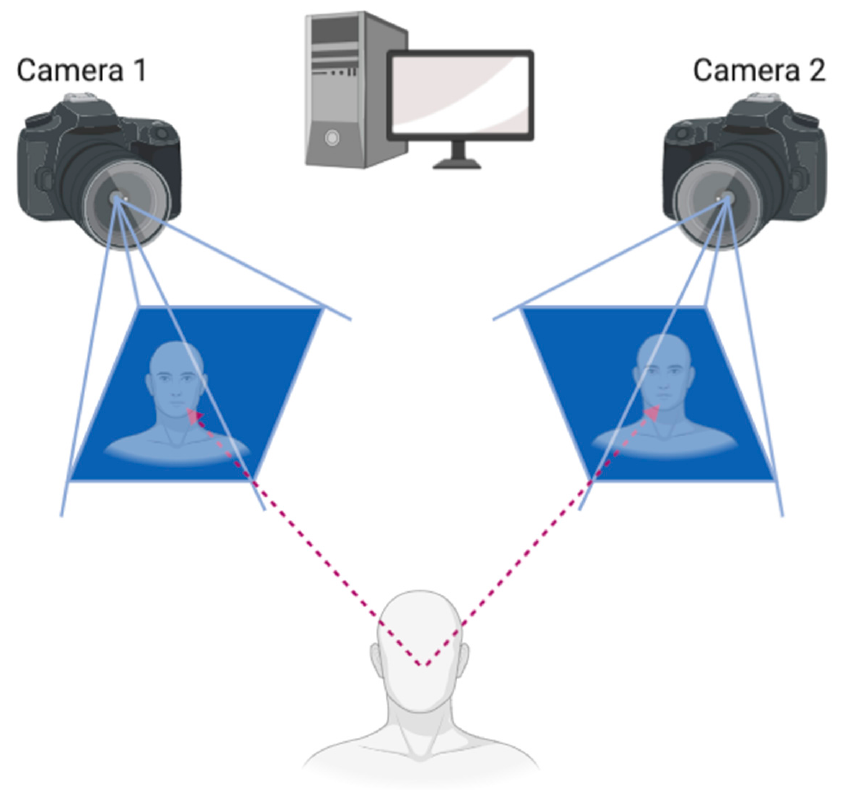
Figure 2. Photogrammetry and stereophotogrammetry requires a designated space for the subject, multiple cameras from various viewpoints surrounding the subject, and a computer to process the images.